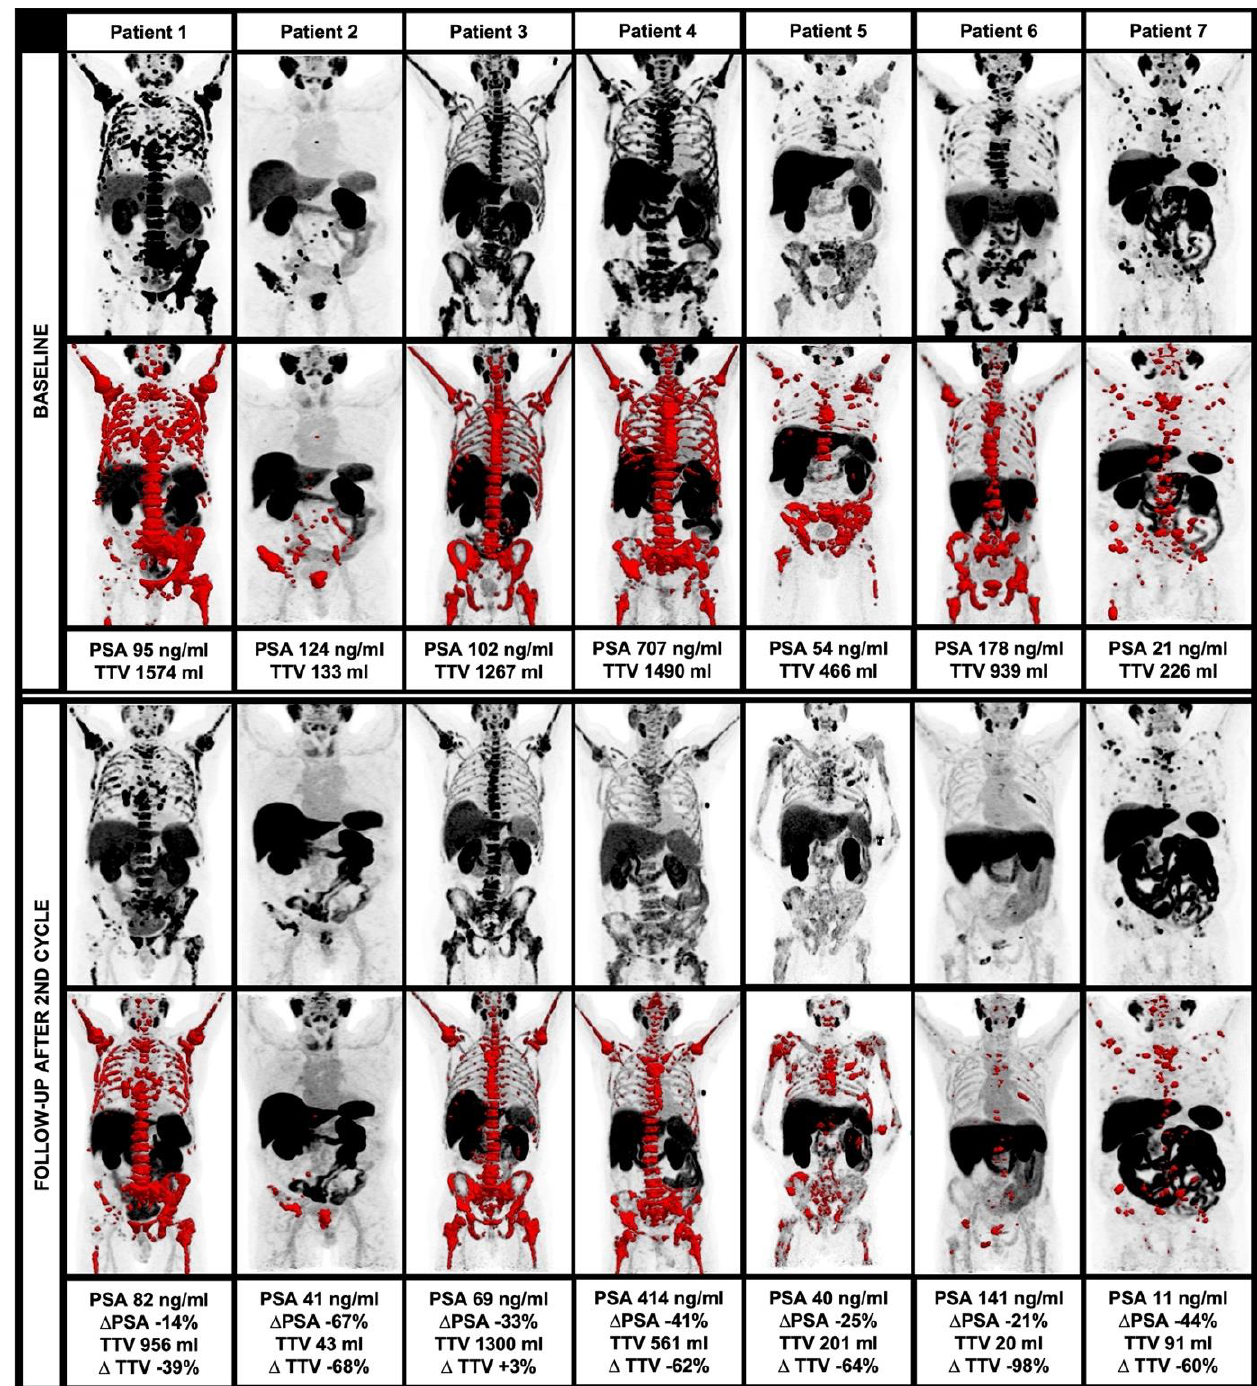
Figure 2. Course of TTV and clinical parameters during alpha therapy, including MIP and TTV (red) at baseline (upper row) and at follow-up after the second therapy cycle (lower row).